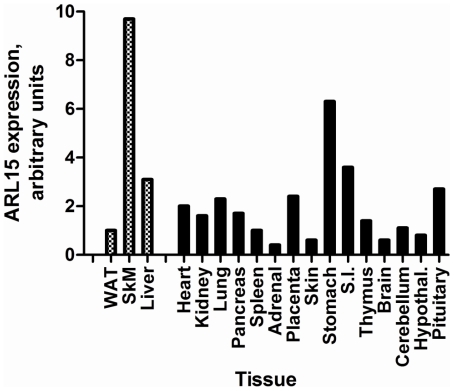
Tissue distribution of ARL15 expression.mRNA levels determined by quantitative real-time PCR in a panel of human tissues.